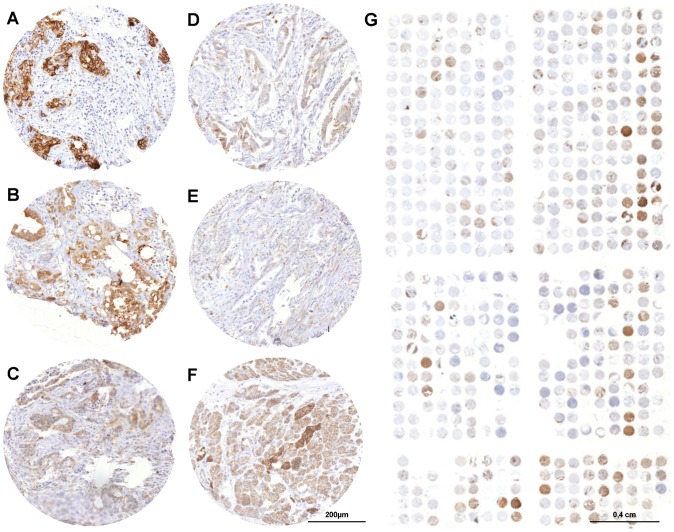
Representative immunohistochemical ALCAM stains of primary pancreatic cancer (PAC) lesions.(A) and (B) strong ALCAM expression, (C) and (D) medium and (E) no expression. (F) Healthy pancreatic tissue. (G) Complete scan of the PAC tissue microarray.